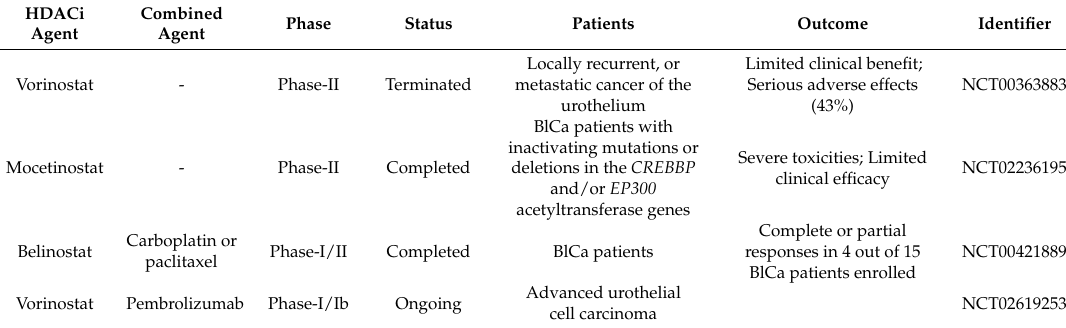
Table 2. Clinical trials of HDACis in urothelial bladder cancer (BlCa: Bladder Cancer)